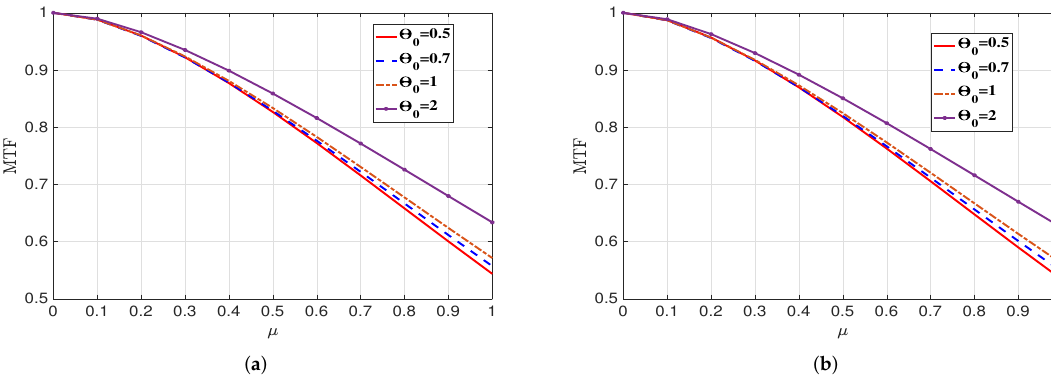
Figure 4. Long-exposure MTF as a function of normalized spatial frequency for collimated ( Θ 0 = 1), divergent ( Θ 0 > 1), and convergent (0.5 < Θ 0 < 1) Gaussian beam waves in ( a ) terrestrial atmospheric